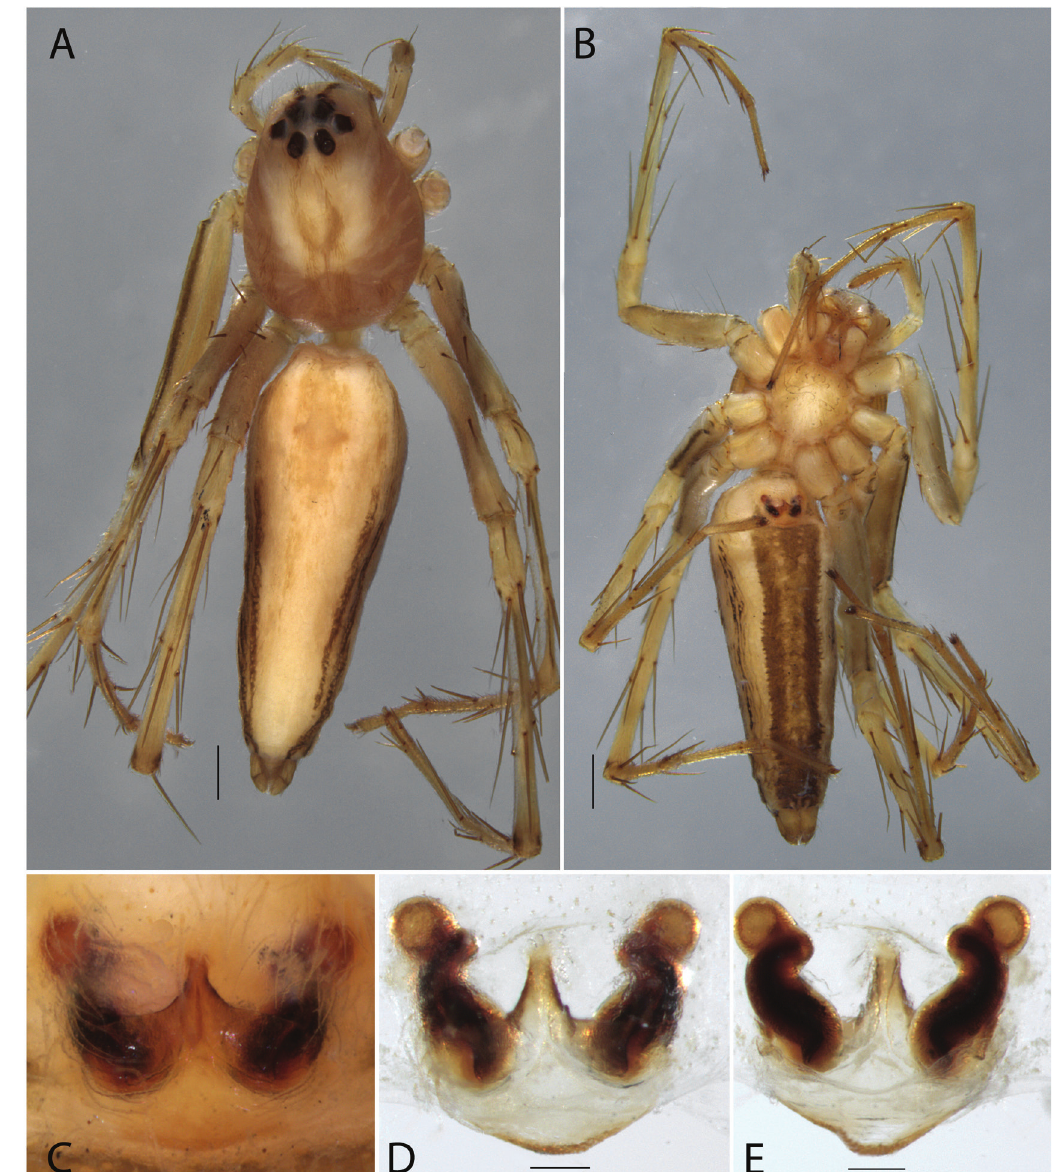
Figure 10. Oxyopes macilentus L. Koch, 1878, female lectotype (ZMH- A0000012): A , habitus, dorsal view; B , habitus, ventral view; C , epigyne, ventral view; D, epigyne, ventral view, cleared; E , epigyne, dorsal view, cleared. Scale bars: habitus 1.0 mm, epigyne 0.1